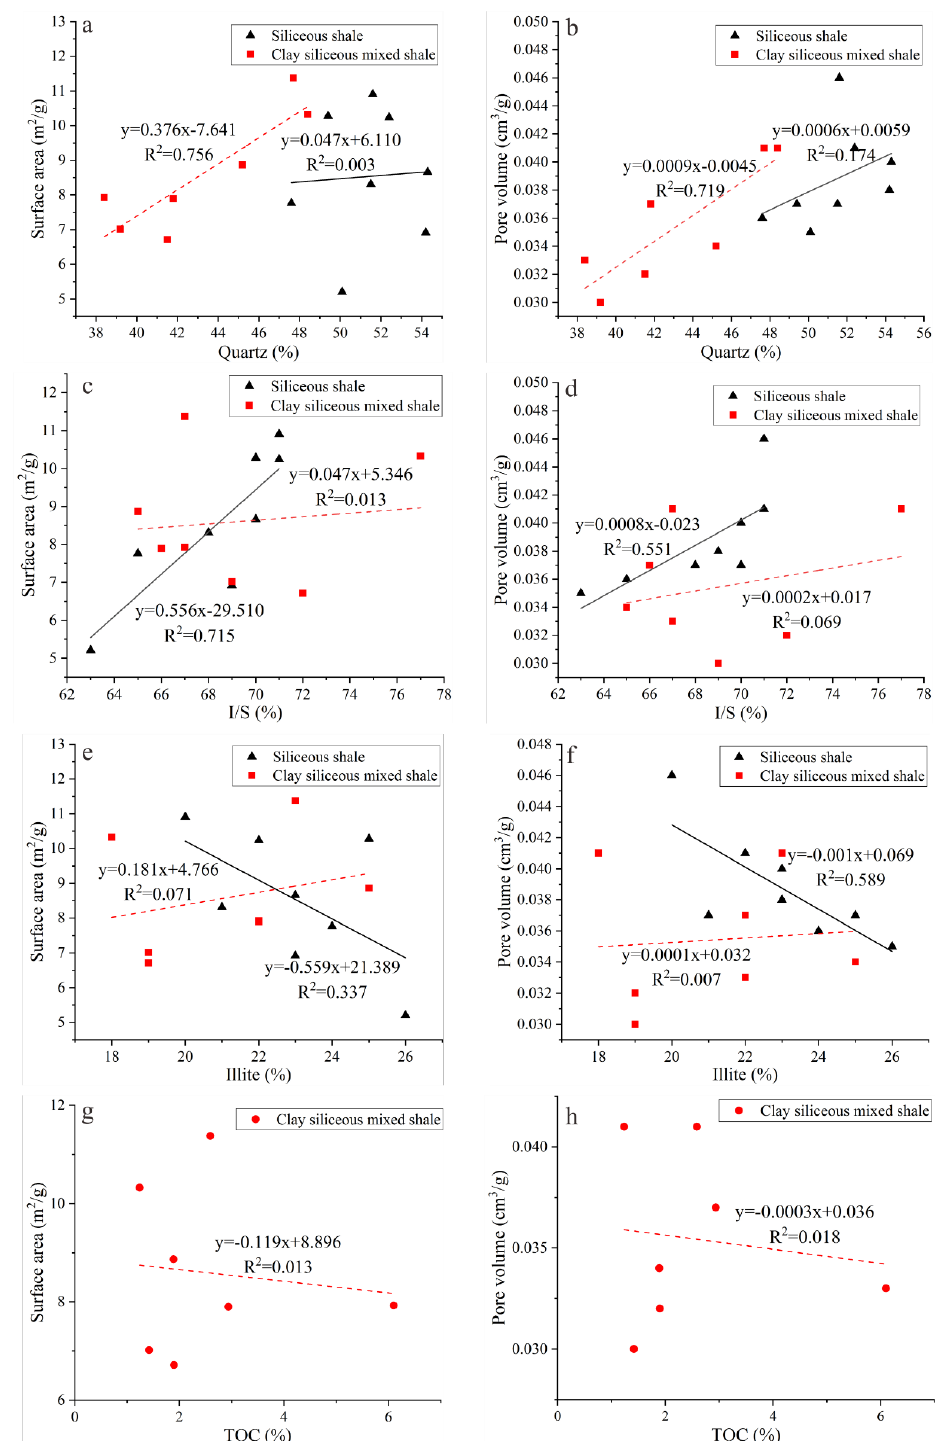
Figure 13. Relationships between quartz, I/S, illite, TOC content, and SA, PV among different shale lithofacies. ( a ) realtionships between quartz and SA among differnet shale lithofacies; ( b ) realtionships between quartz and PV among differnet shale lithofacies; ( c ) realtionships between I/S and SA among differnet shale lithofacies; ( d ) realtionships between I/S and PV among differnet shale lithofacies; ( e ) realtionships between illite and SA among differnet shale lithofacies; ( f ) realtionships between illite and PV among differnet shale lithofacies; ( g ) relationship between SA and TOC in clay-siliceous mixed shale; ( h ) relationship between PV and TOC in clay-siliceous mixed